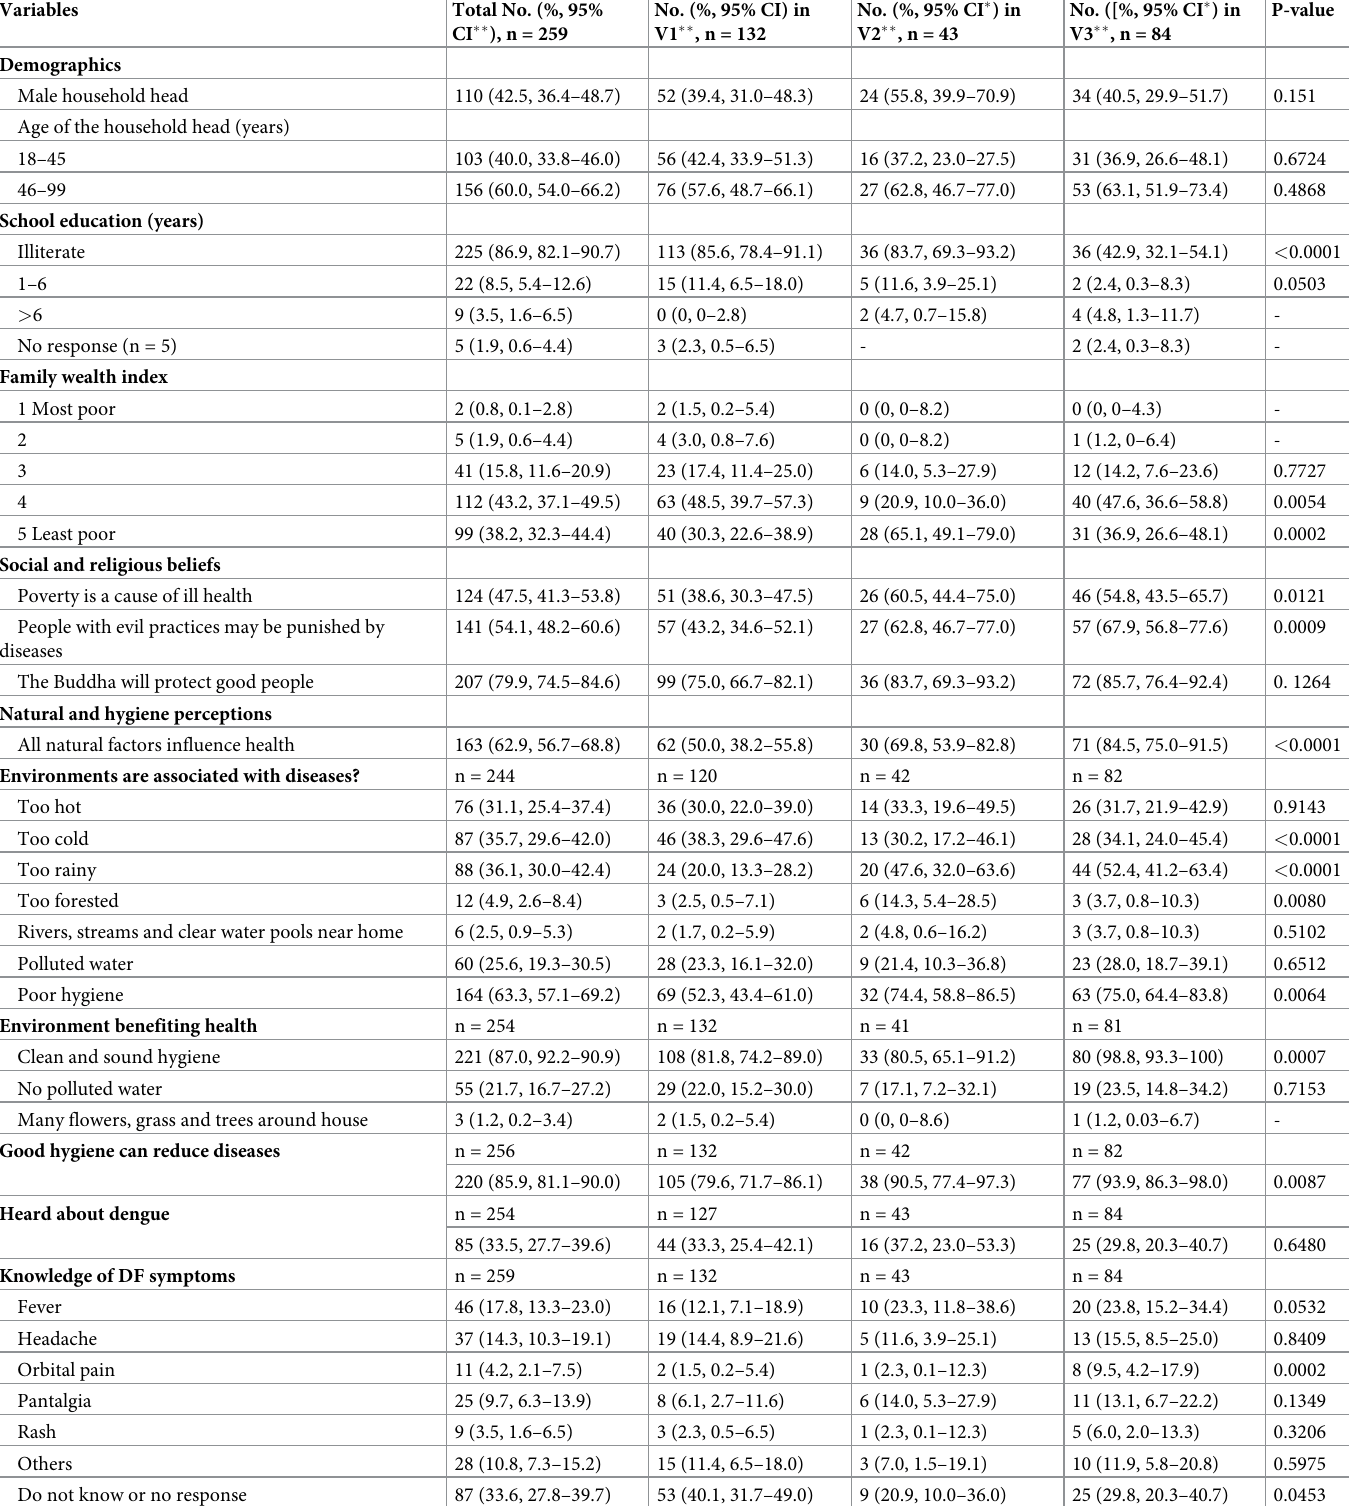
Table 3. Results of the household questionnaire survey in Eastern Shan Special Region IV,